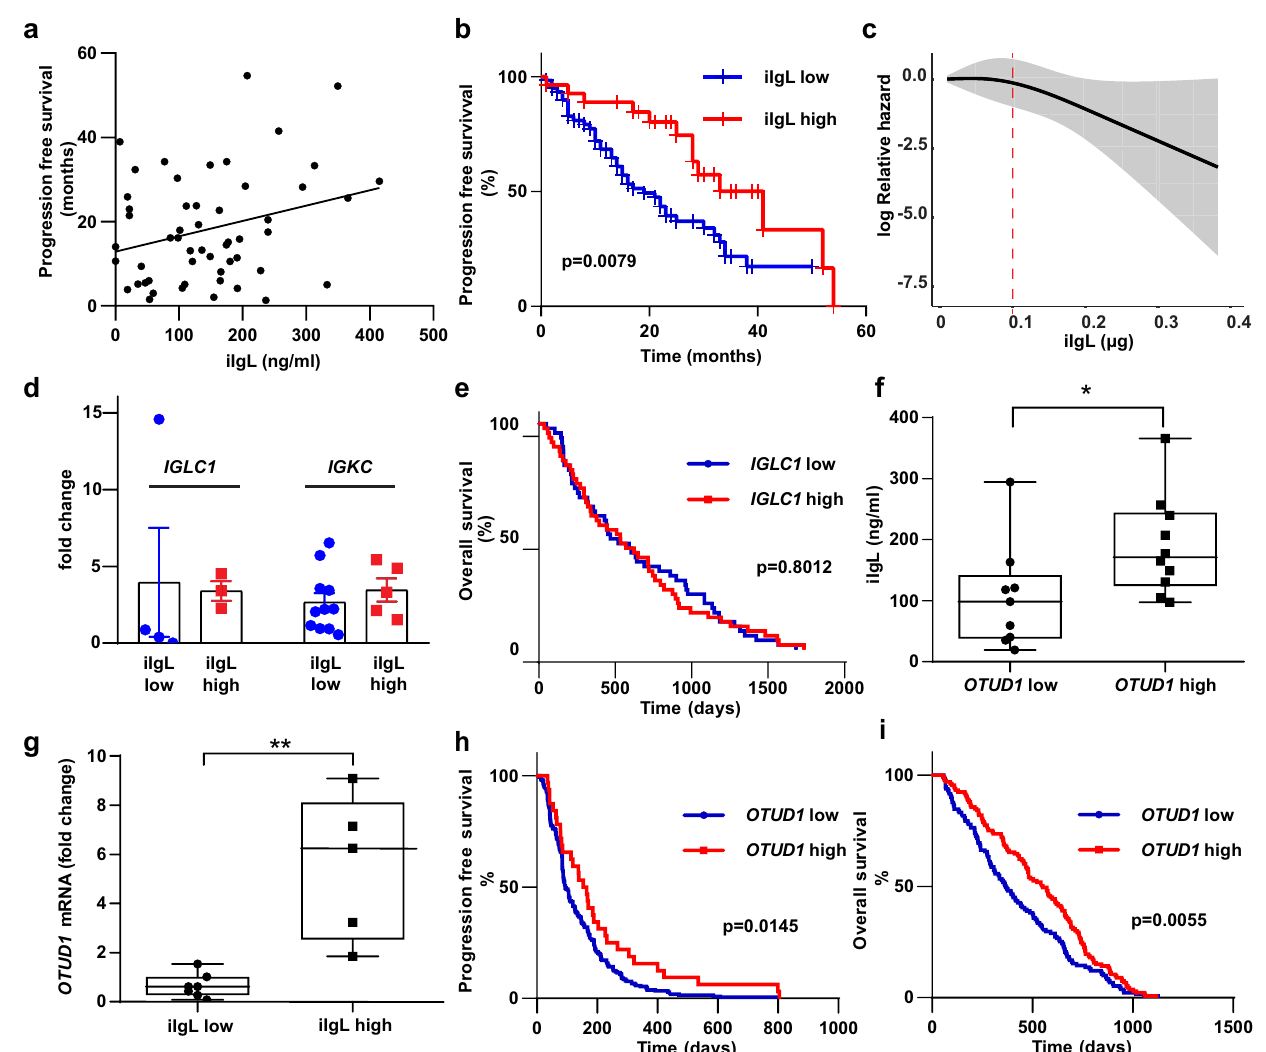
Fig. 1 | iIgand OTUD1are predictors ofmyelomasurvival. a Correlation analysis of iIgL and PFS of the newly diagnosed MM patients ( n =53). iIgL was quanti fi ed usingELISAinlysatesfromaberrantplasmacellssortedusingthemyeloma-speci fi c panel. Signi fi cance of regression coef fi cient was determined by F -test (DF n =1, DFd=51, p =0.0387; R square=0.08112, 95% Con fi dence Intervals: slope 3.921 to 141.6, Y-intercept 6.807 to 18.99, X-intercept − 4.577 to − 0.05085) b PFS was eval- uated in MM patients ( n =86) divided into two groups based on the iIgL content. iIgL high (red) and iIgL low (blue) groups were determined by the median iIgL concentration (0.1 μ g iIgL/ μ g total plasma cell proteins). Signi fi cance was com- pared using the log-rank (Mantel-Cox) test ( n =59 for iIgL low, n =27 for iIgL high, p=0.0079). c Cubic splines analysis (knots=3) showing log relative hazard of progression as a function of the level of iIgL. Shaded area represents 95% con- fi denceintervals. d Expressionof IGLC1 and IGKC wasanalyzedbyRT-PCRintheiIgL highandiIgLlowgroupsfrom( b ),( IGLC1:n =5foriIgLlow, n =5foriIgLhigh; IGKC : n =9 for iIgL low, n =5 for iIgL high). Signi fi cance was compared using the two-